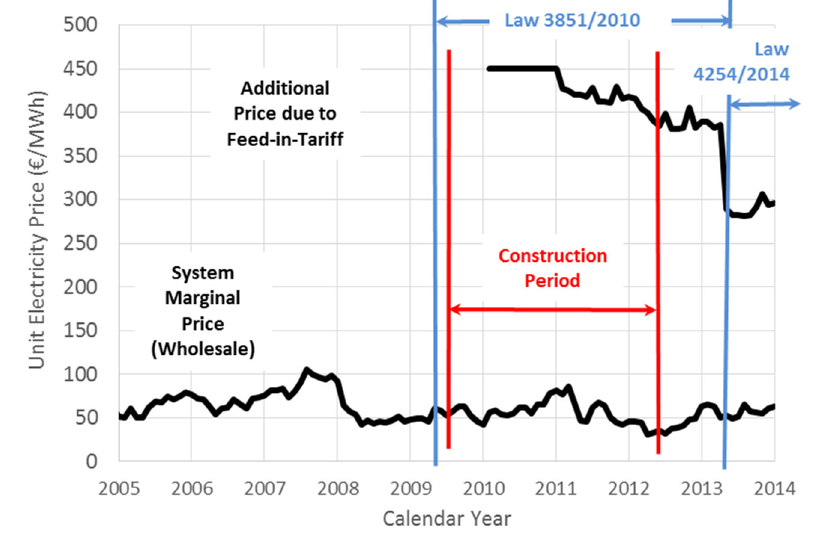
Figure 6. Feed-in-tariff and system marginal price evolution. Data from Hellenic Electricity Market Operator